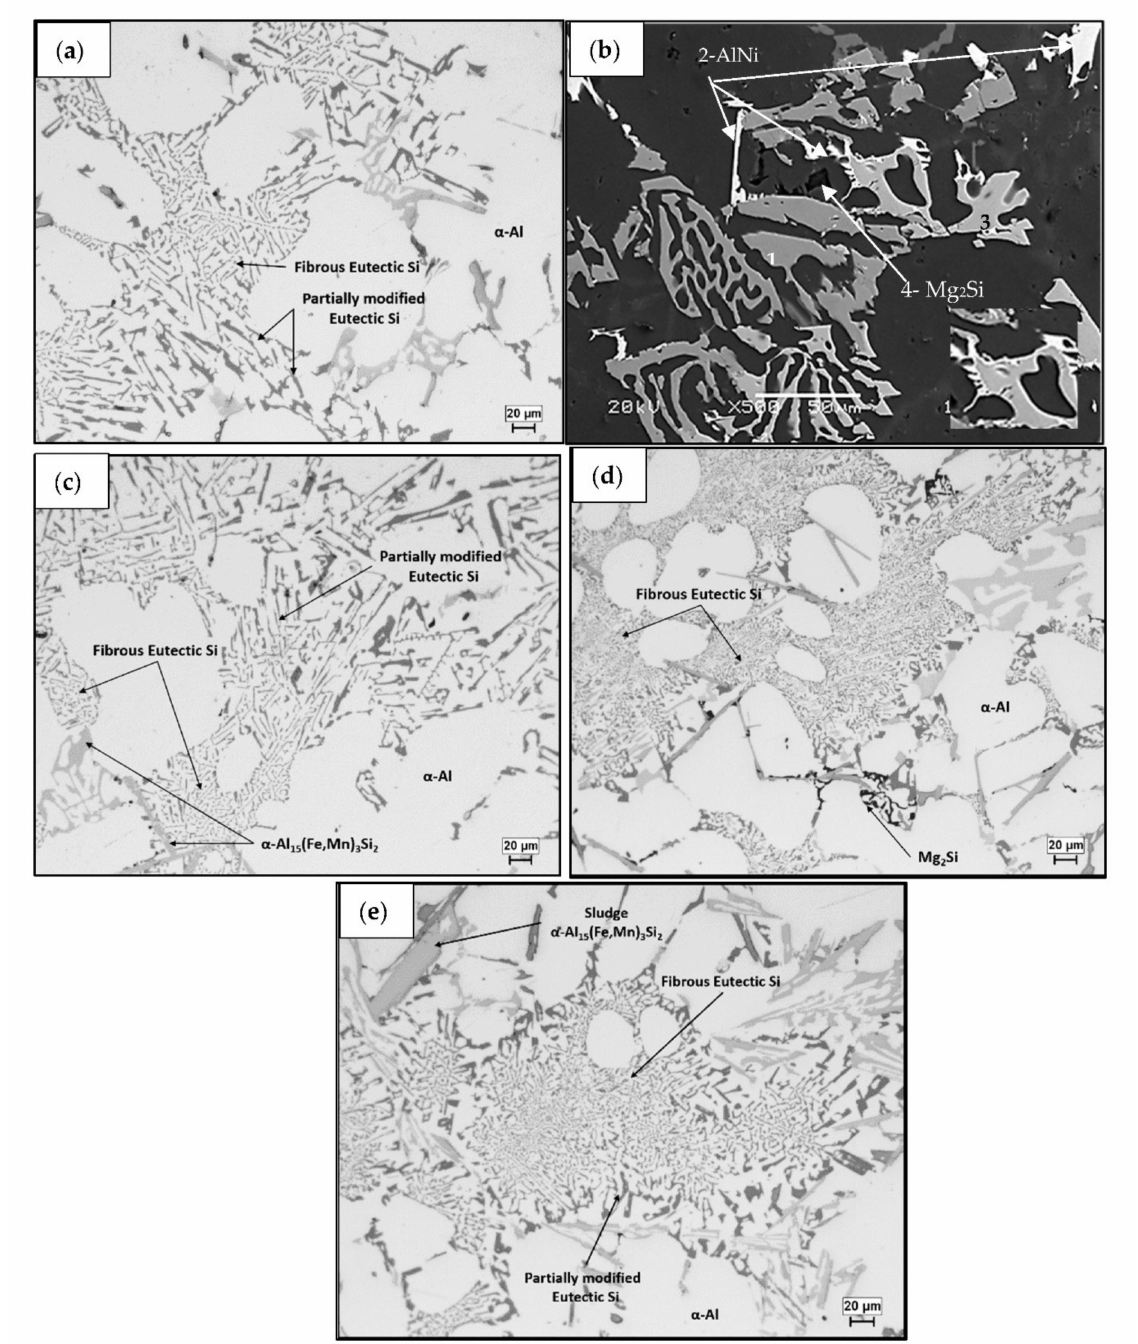
Figure 1. Optical microstructures of: ( a ) M1S alloy, ( b ) backscattered electron image of M2S alloy showing a mixture of 1- AlFeNi, 2-AlNi, 3-AlCuNi, and 4-Mg 2 Si phases. Note the precipitation of AlNi phase particles on the edges of AlCuNi particles in the inset micrograph ( c ) M3S alloy, ( d ) M4S alloy, ( e ) M5S